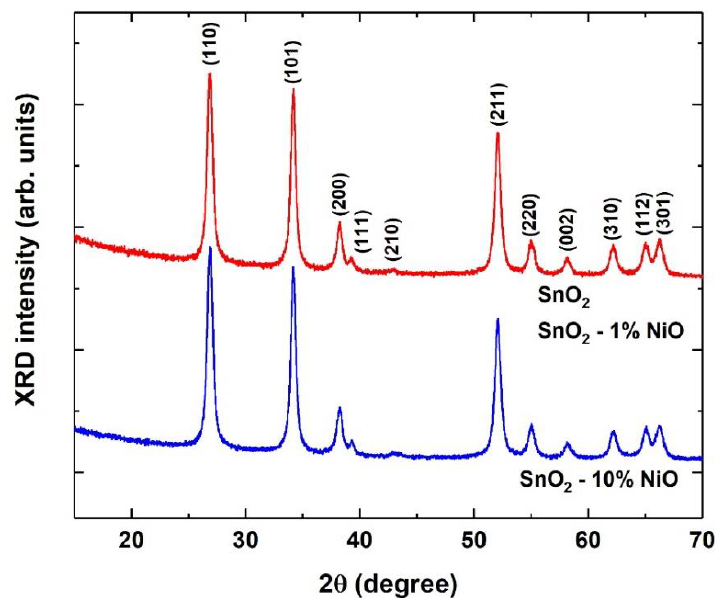
Figure 2. XRD patterns of the SnO 2 and NiO loaded SnO 2 samples indexed with the SnO 2 tetragonal structure. The X-ray diffractograms are vertically shifted for clarity.